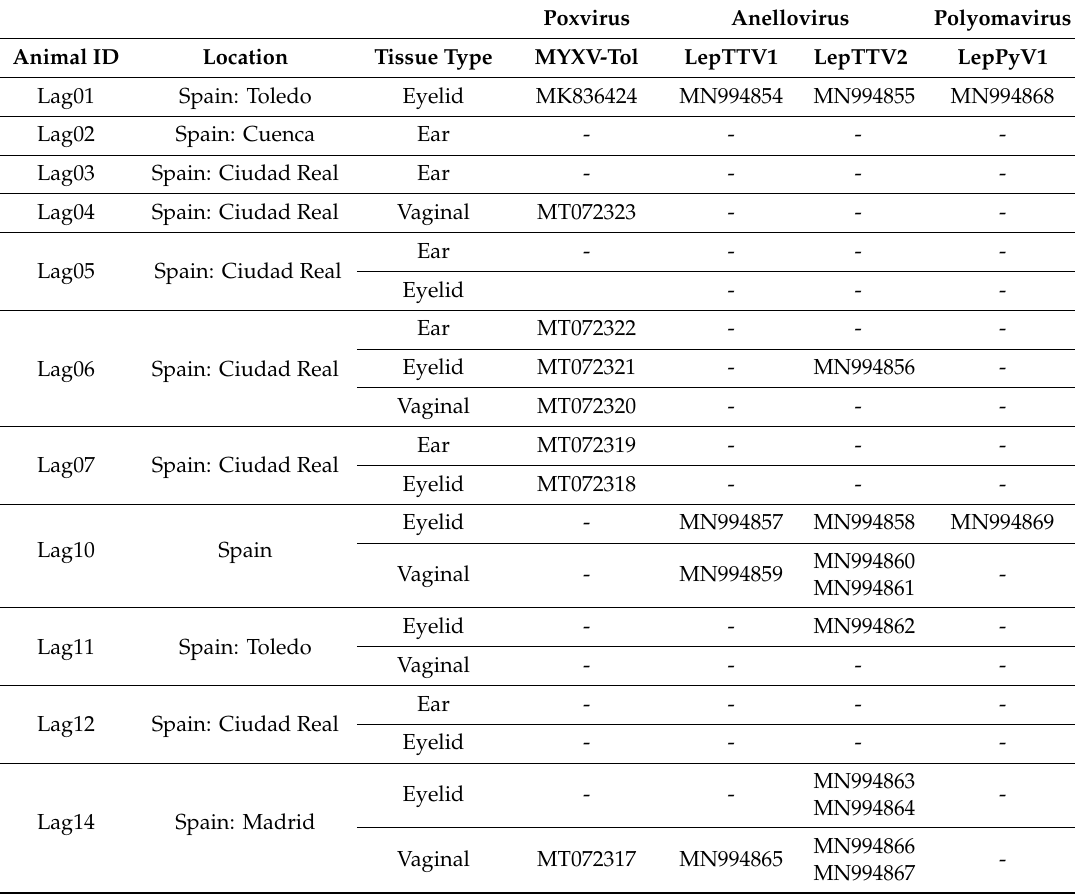
Table 1. Sample information of the hare samples analyzed in this study including geographic origin, tissue type and GenBank accession numbers of the viral